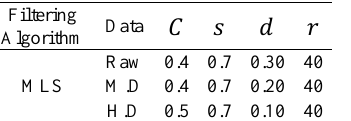
Table 2. The parameters used in the MLS algorithm (M.D stands for medium-density and H.D means high-density) The optimum parameters used in the ETEW algorithm are shown in Table 3. The slope and iteration number parameters were found to be the most effective ones with regard to the performance of the ETEW algorithm. The parameters used in the ETEW algorithm are as follows; Cell size ( 𝐶 ) is the initial size of each grid and can be chosen as the average distance among the points in data (Montealegre et al., 2015). Slope ( 𝑠 ) is the threshold parameter for slope. Iteration number ( 𝑖 ) indicates how many times the algorithm will iterate (Zhang and Cui, 2007).